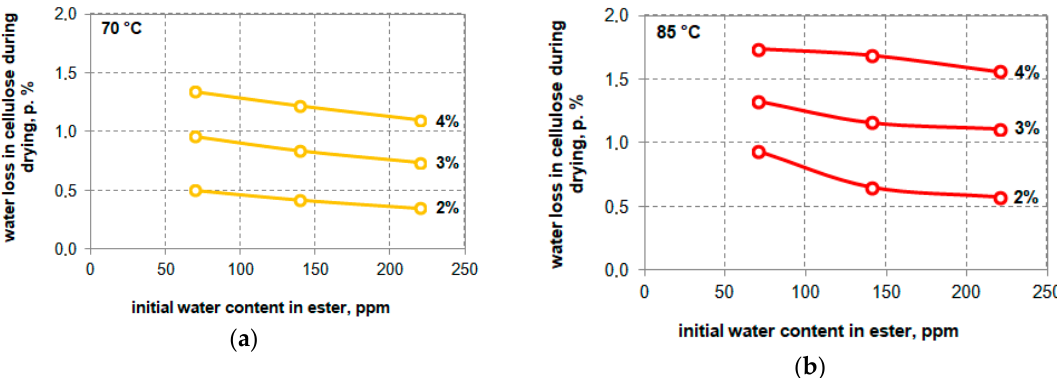
Figure 8. Water loss in cellulose in percentage points depending on the initial moisture of the three times introduced ester; initial moisture of cellulose 2%, 3%, and 4%, insulation thickness 3 mm, mass ratio of cellulose to ester 0.067, drying time 168 h; temperature 70 °C ( a ) and 85 °C ( b ).